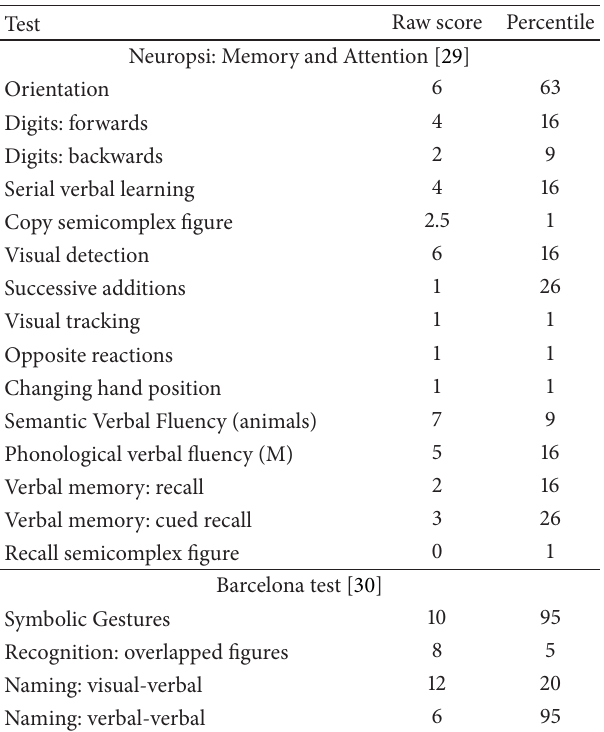
Table 1: General results of neuropsychological